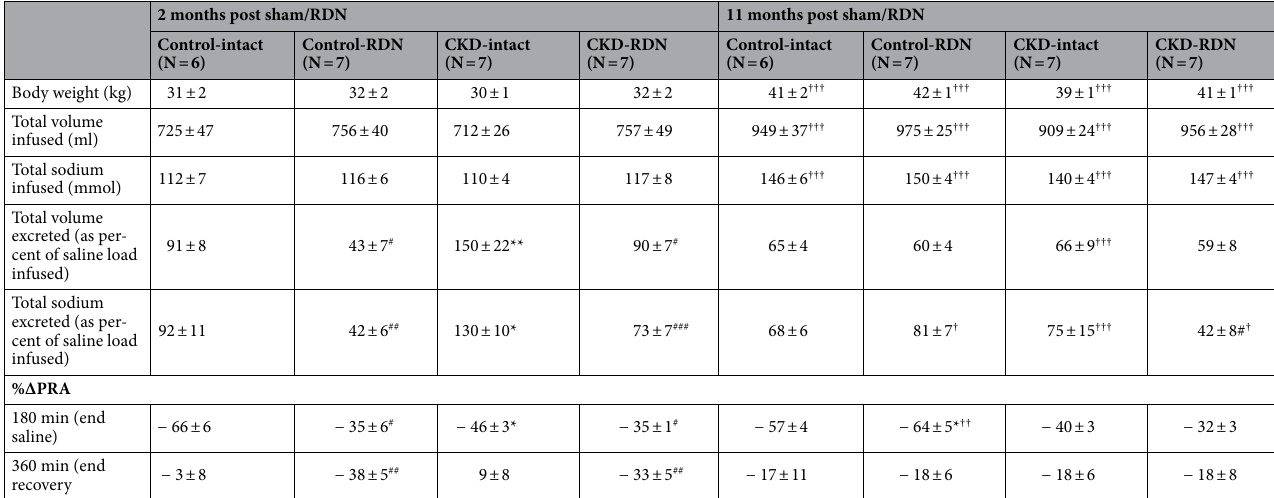
Table 1. Total volume and sodium infused and excreted and change in plasma renin activity in response to isotonic saline loading. %∆PRA; percent change in PRA from baseline; *P < 0.05, **P < 0.01 comparing between intact groups within age, # P < 0.05, ## P < 0.01, ### P < 0.001 comparing between intact and RDN groups